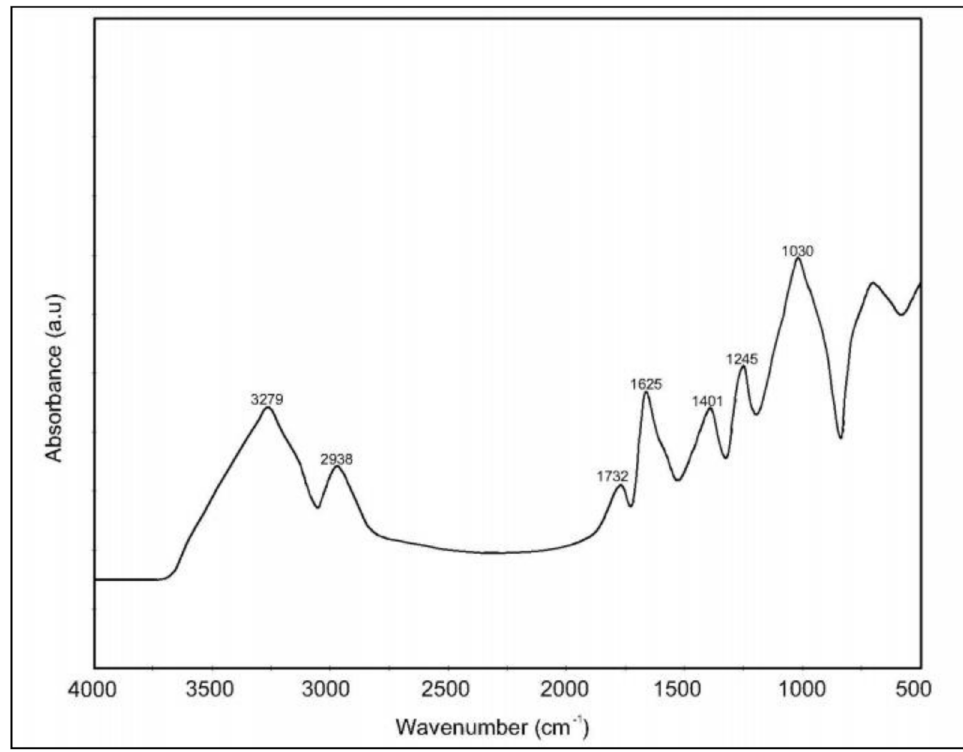
Figure 1. FT-IR spectrum of okra